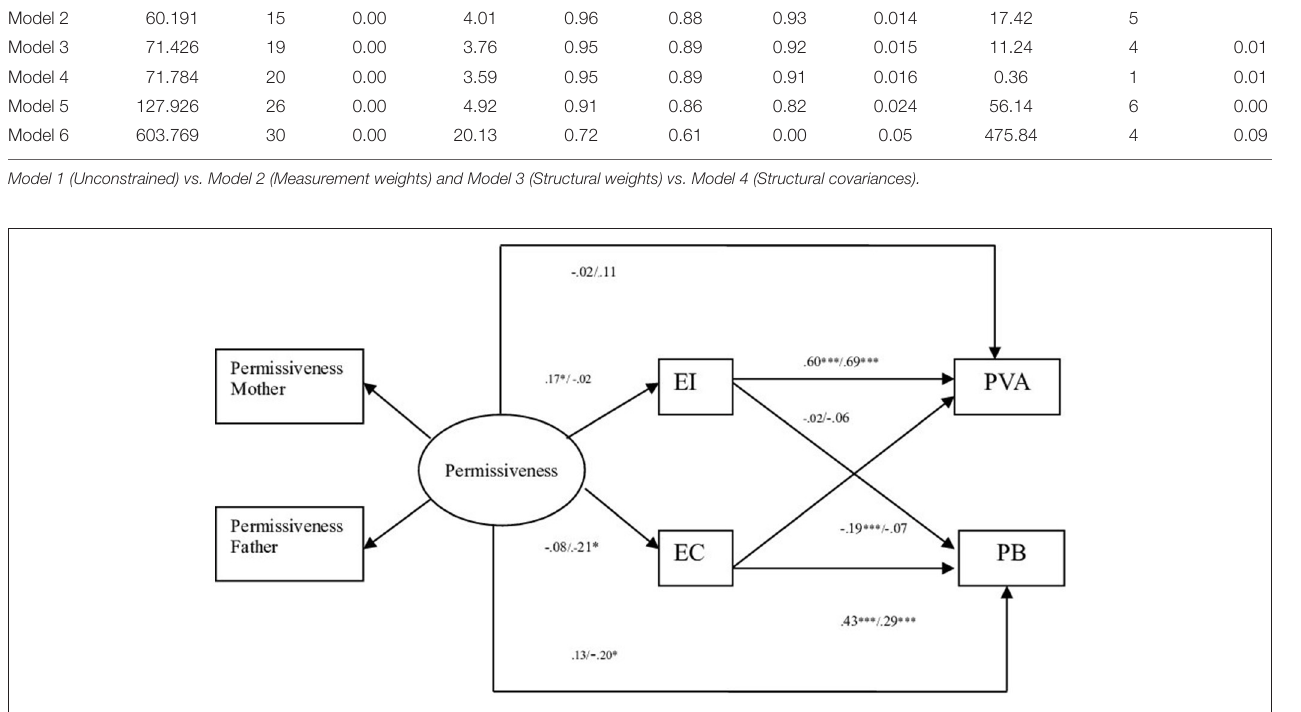
FIGURE 4 | Path standardized coefficient values of offenders and non-offenders pertinent to parental style permissiveness. Standardized Values. EI, Emotional Instability; EC, Empathic Concern; PVA, Physical and Verbal Aggressive Behavior; PB, Prosocial behavior. *** p < 0.001, * p < 0.05. Non offenders left value, offenders right